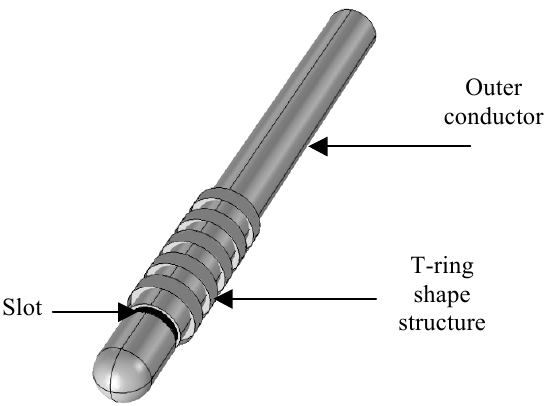
Figure 2: The new single slot MCA with T-ring shape structure wrapped around the outer conductor Dimensions of the T-ring shape (Figure 3) are small compared to the effective wavelength in the liver, at the operating